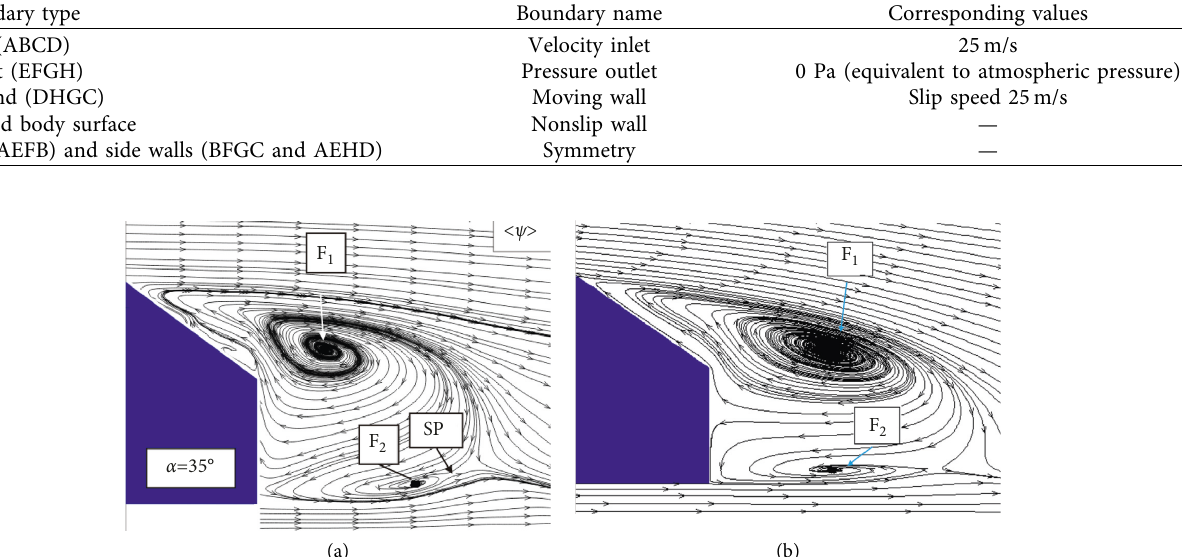
Figure 5: Comparison of tail flow field distribution on 35 ° Ahmed model xz symmetry plane. (a) experiment and (b) simulation.